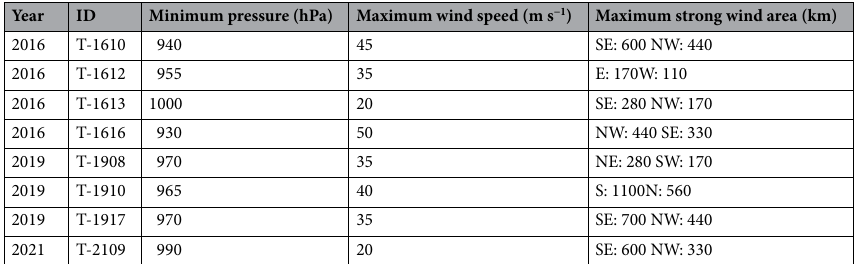
Table 1. Characteristics of the typhoons during which muographic data were collected 48 . A strong wind area is defined as an area where the wind speed exceeds 15 m s −148